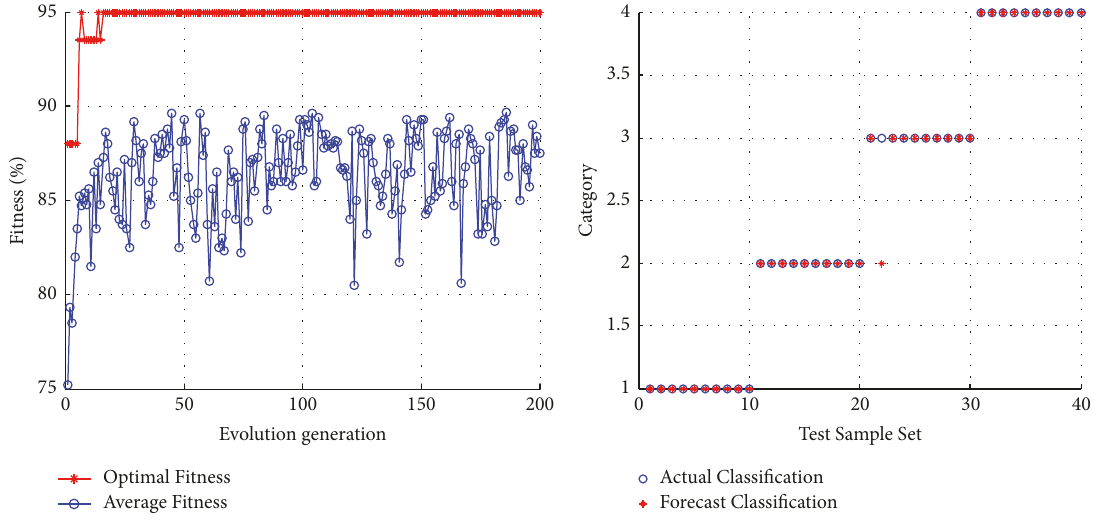
Figure 15: Classification training and test results based on GA.